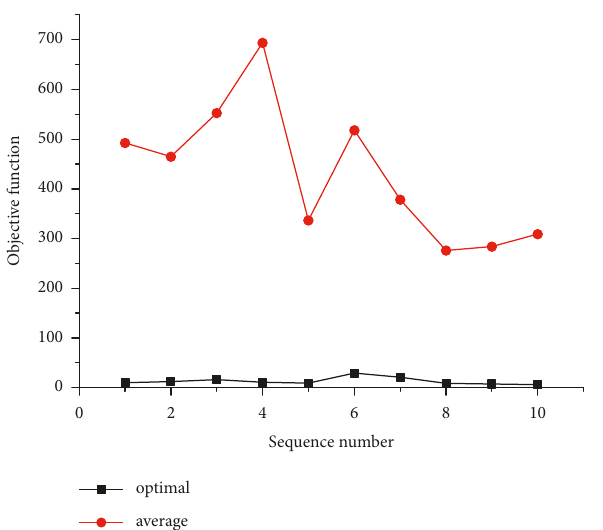
Figure 5: The influence of the initial population on the objective function.